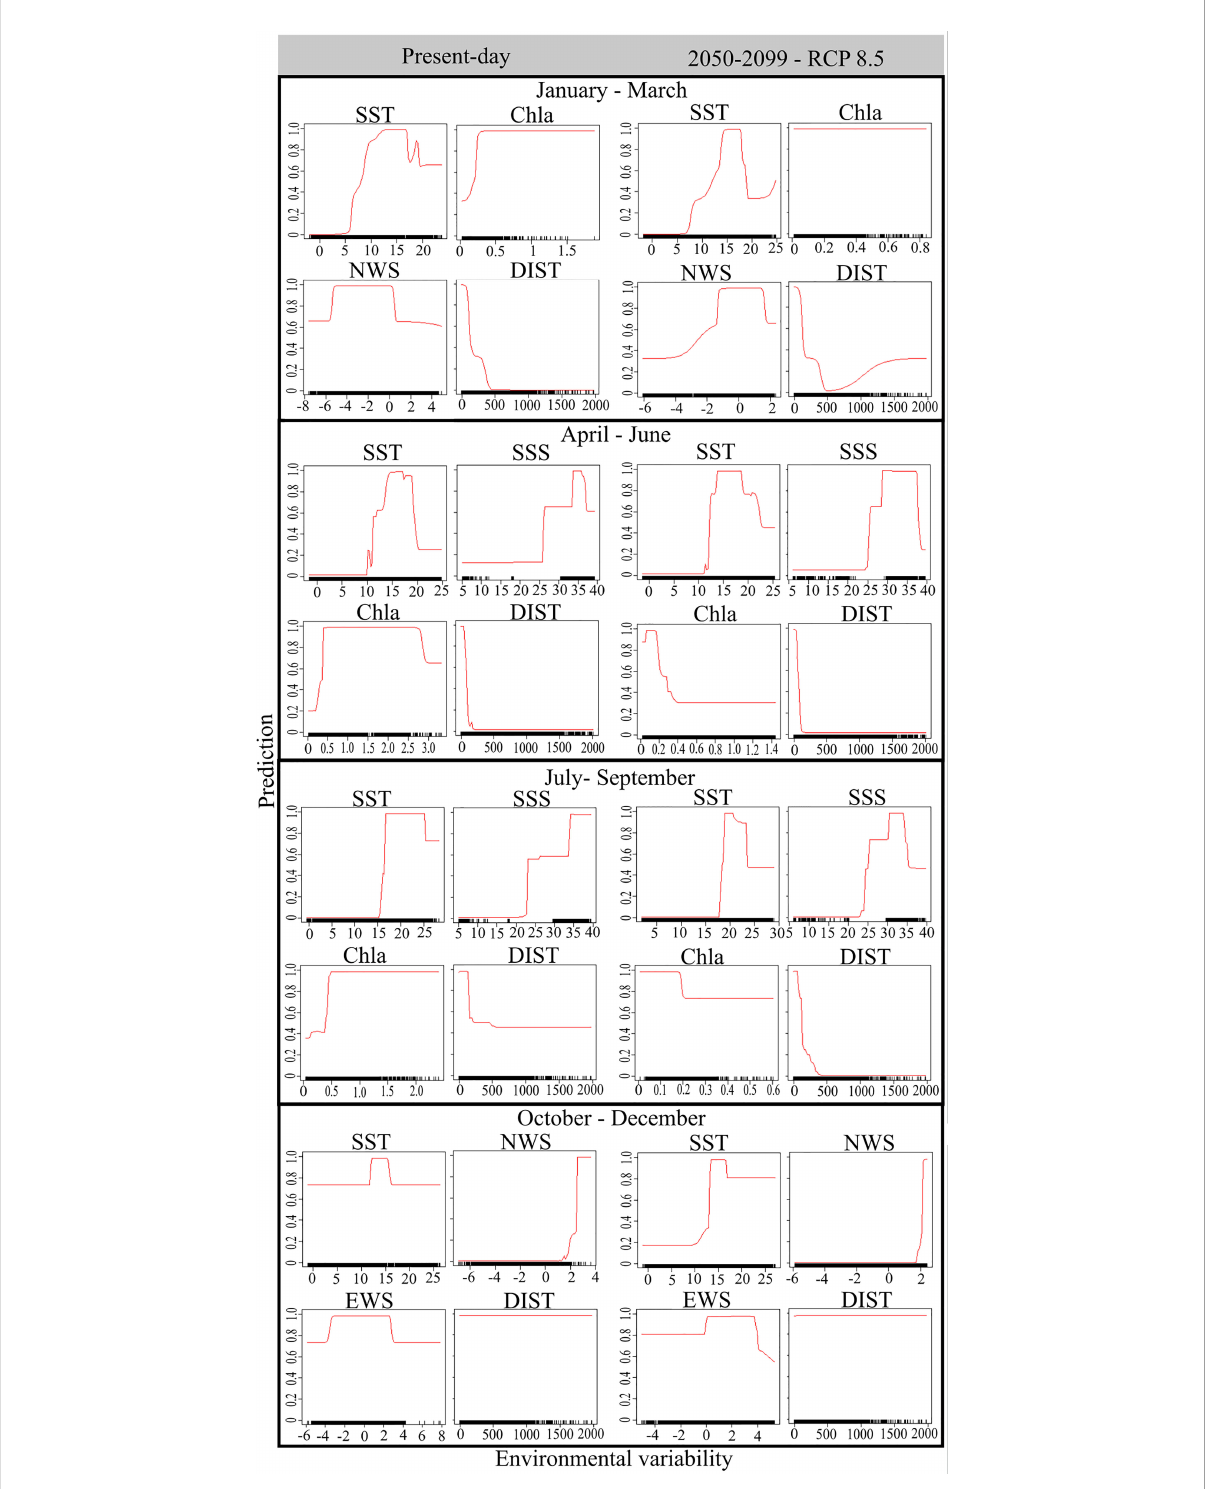
FIGURE 1 Relative importance of the selected environmental variables showing the plots of the effects of single variables for each seasonal period during the present-day and future scenarios. The y -axis re fl ects the suitability coef fi cients (solid red lines) of the ensemble model. The dashes on the x - axis, the so-called ‘ rug ’ , indicates the density of points for the different suitability coef fi cients of each